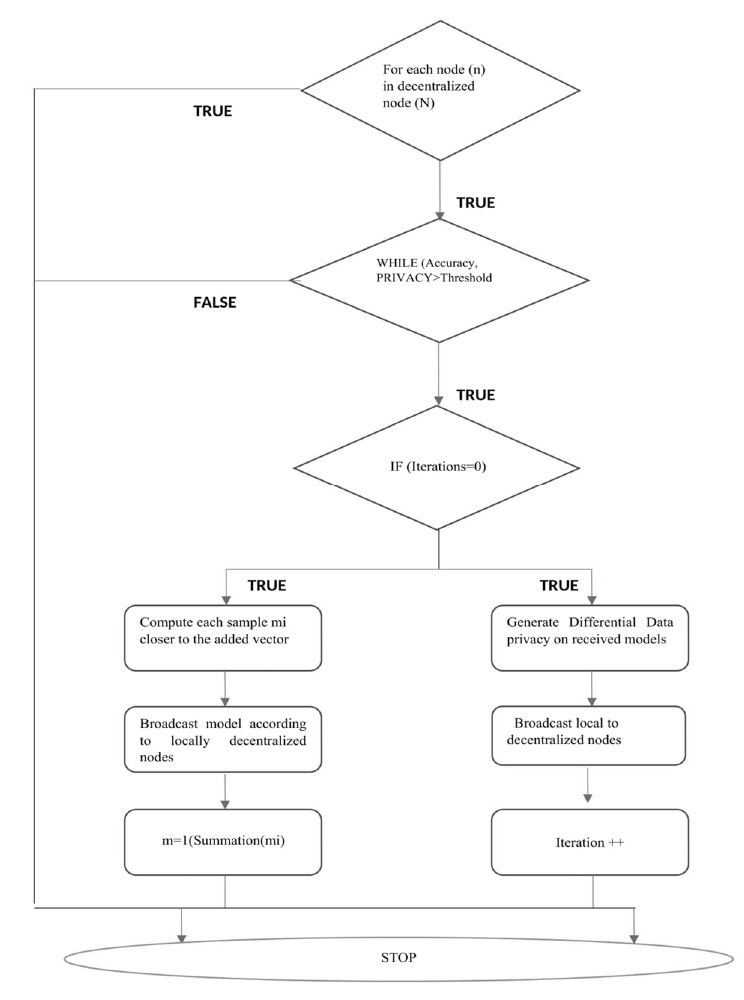
Figure 5. Privacy-preserving FL flow chart.